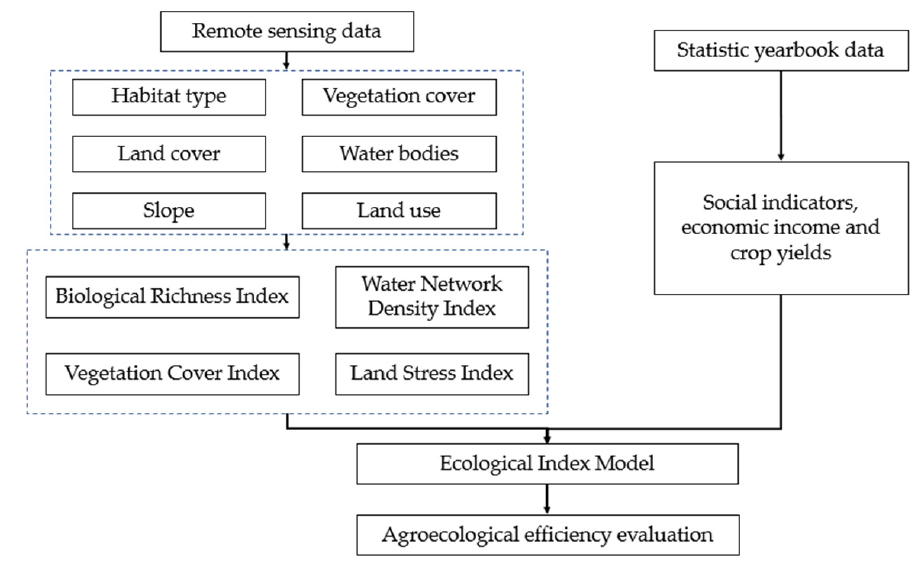
Figure 2. Flowchart of Rangtang County agroecological efficiency evaluation.